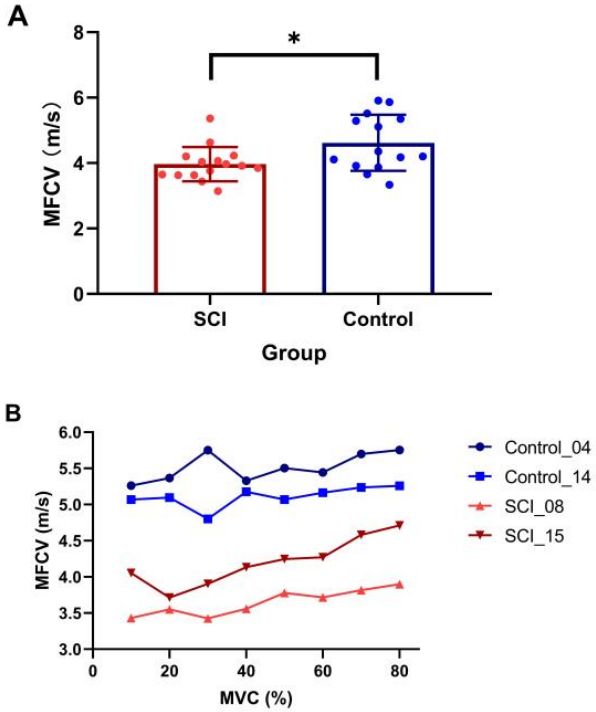
Figure 2. Comparison of MFCV between SCI and control subjects. ( A ) Mean and individual MFCVs in each group (* p < 0.05, error bar represents standard deviation); ( B ) MFCV at the different target forces in two subjects from SCI and control groups, respectively.